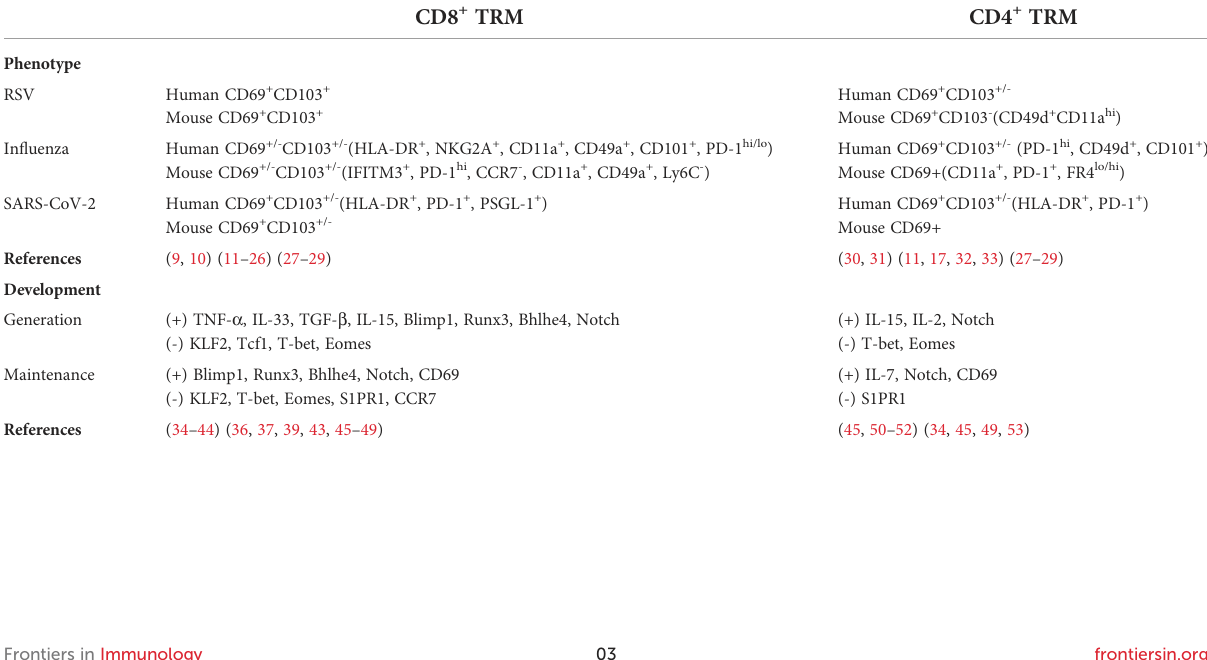
TABLE 2 phenotypes of CD8 + and CD4 + TRM cells in respiratory viruses, as well as cytokines and transcription factors in the regulation of pulmonary TRM